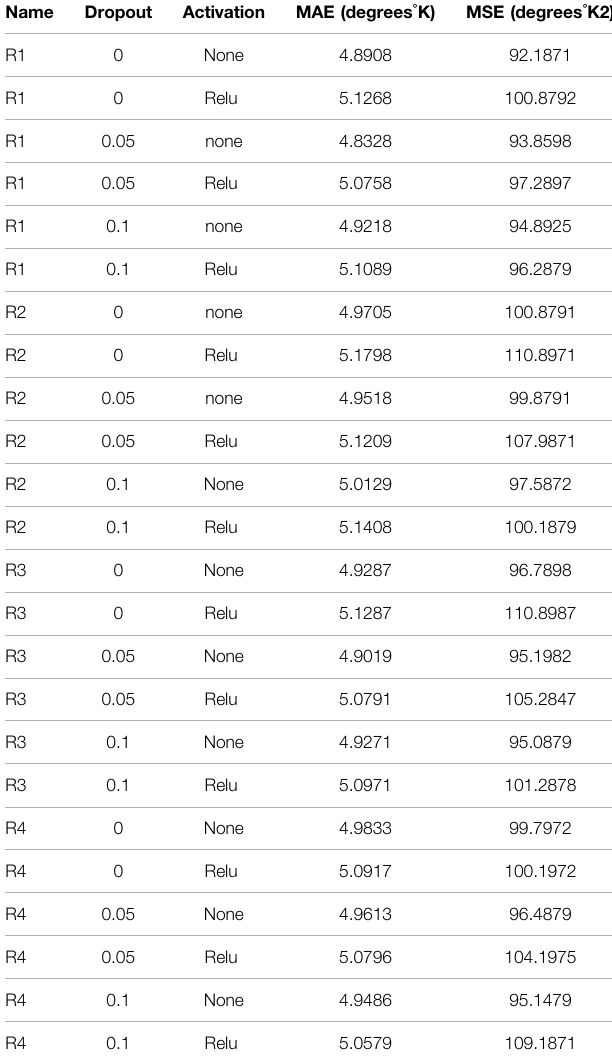
TABLE 1 | Results of training of recurrent neural